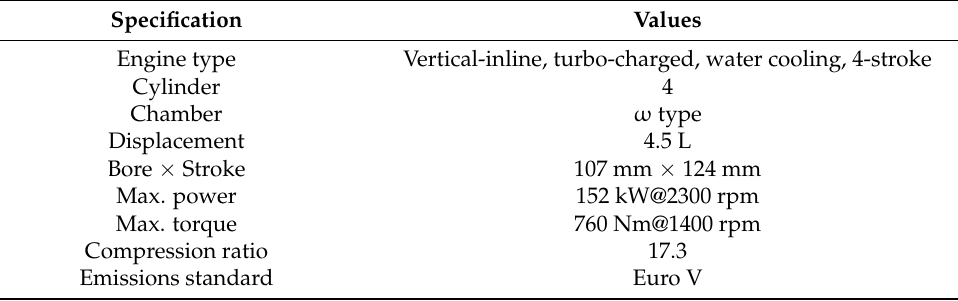
Figure 4. Experimental test rig of NOx emissions of diesel engine [24]. Table 2. Specification of the tested diesel engine [24].